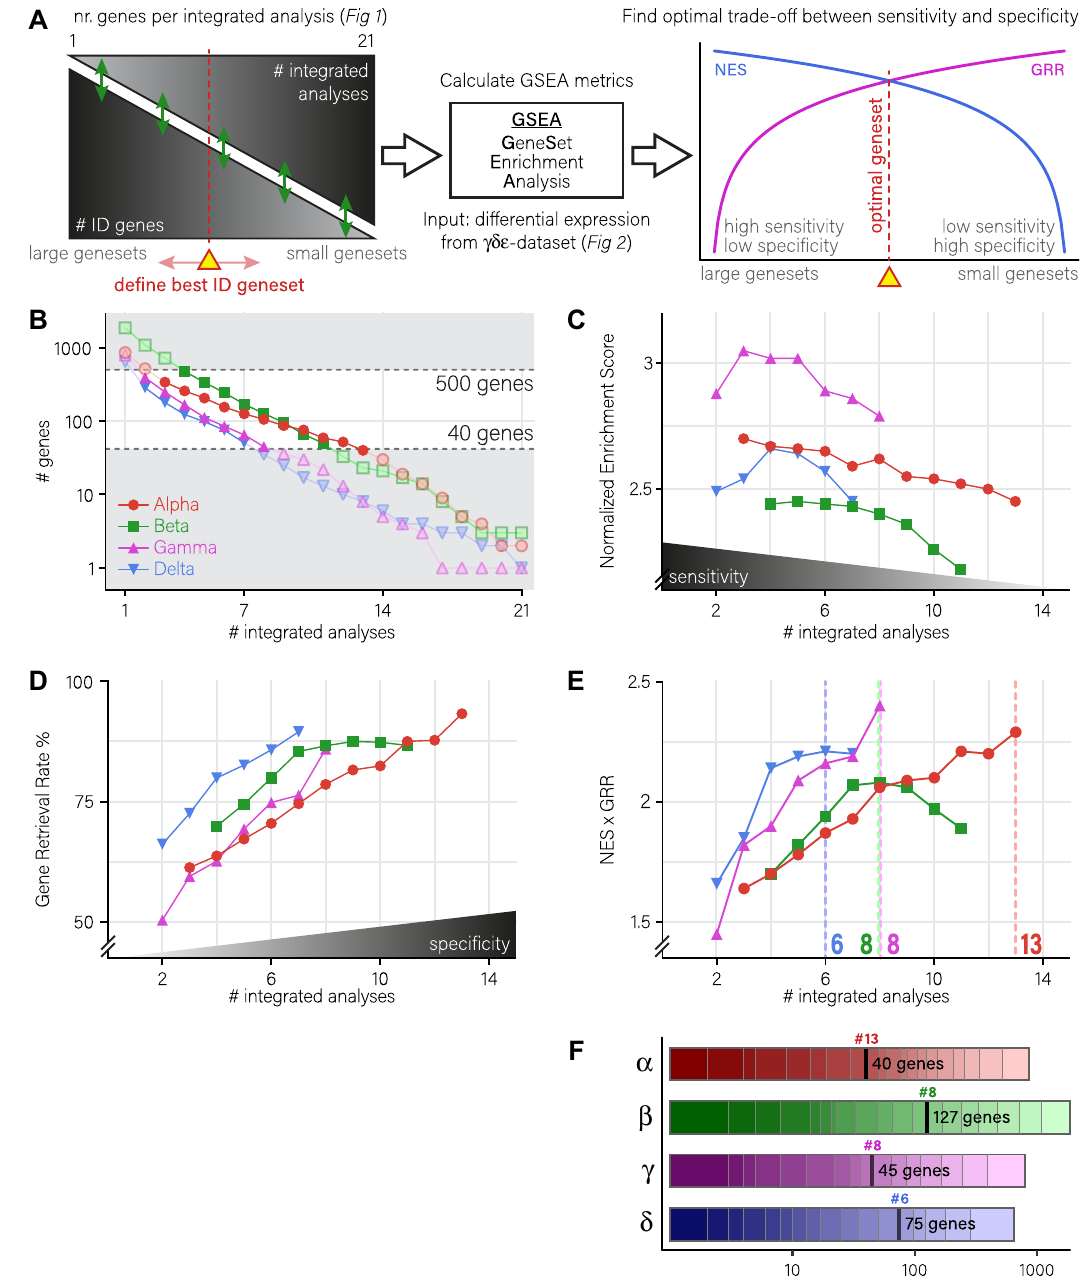
Fig. 3 Generation of islet cell type-speci fi c identity genesets. A Methodology to determine the optimal genesets from our lists of identity genes. First, 21 incrementally smaller genesets were generated per cell type, including genes with an increasingly higher number of integrated analyses. To de fi ne the best identity geneset, we used GSEA to generate normalized enrichment scores (NES; proxy for geneset sensitivity) and gene retrieval rates (GRR; proxy for geneset speci fi city) based on differential expression in our γδε -dataset. The optimal geneset was de fi ned as the geneset with the highest combined NES/GRR metrics. B Geneset sizes for each cell type, regarding every possible intersect level. Genesets were fi ltered to contain between 40 and 500 genes (darker colours). Genesets outside this range (lighter colours) were not considered for downstream evaluation. C Mean sensitivity score (normalized enrichment; n = 3 independent experiments) for each geneset for each cell type. D Mean speci fi city score (gene retrieval rate; n = 3 independent experiments) for each geneset for each cell type. E Multiplication of NES and GRR scores ( n = 3 independent experiments) for each geneset for each cell type. Per cell type, the highest measured value is indicated by a dotted line, and the appropriate number of integrated analyses is indicated on the x -axis. Genesets were de fi ned to include all genes with at least this amount of integrated analyses, resulting in genesets sizes as indicated in the top left corner. F Determination of fi nal geneset sizes by applying the determined # integrated analyses on the lists of ID genes generated in Fig. 1. For each cell type, the determined cut-off is indicted as a thick black line, numbers indicated with a # indicate the cut-off value determined in panel ( E ). α -, β -, γ - and δ -cell genesets in red, green, magenta and blue, respectively. Source data are provided as a source data fi